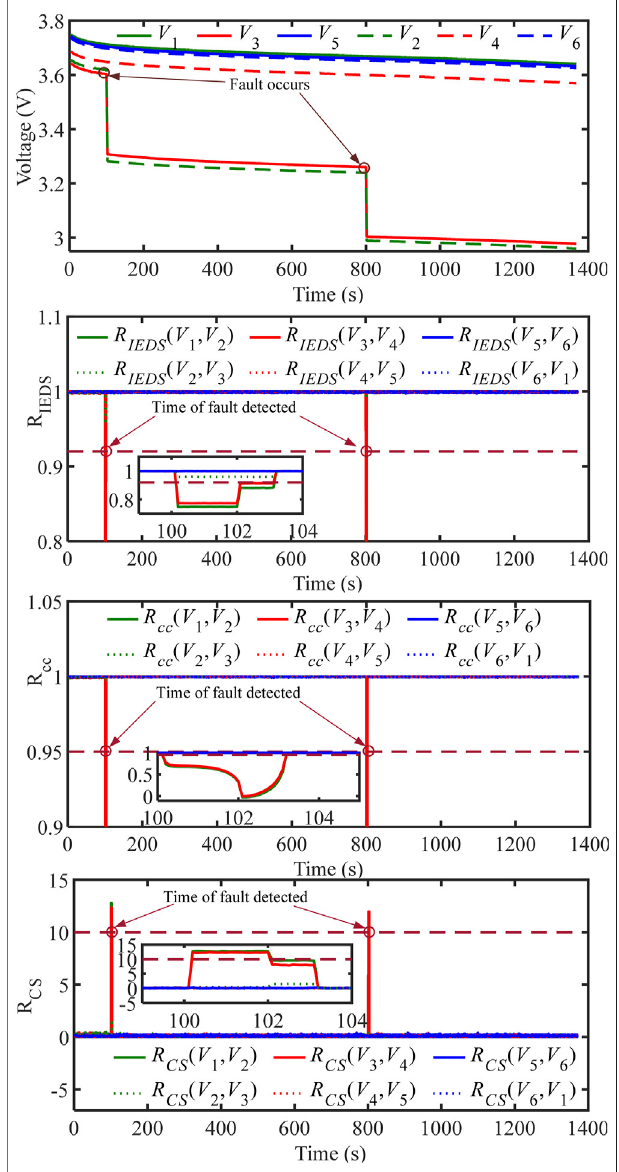
FIGURE 7 | Normal condition evaluation results. (a) Voltage curve. Diagnosis by (b) R IEDS , (c) R cc , (d) R CS .